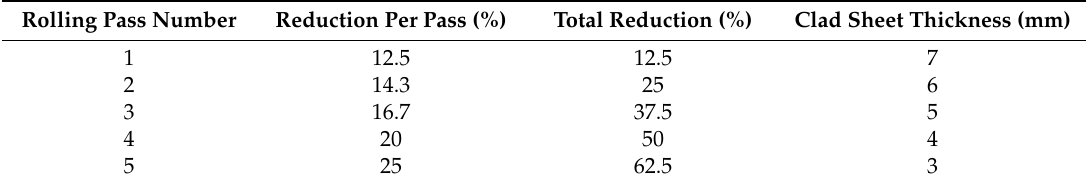
Table 1. The rolling pass number, the reduction per pass, and the clad sheet thickness in the multi-pass rolling process.